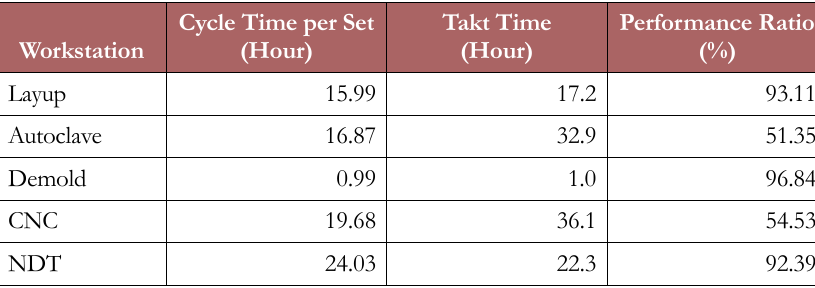
Table 10. Performance ratio computed from comparison of cycle time and Takt